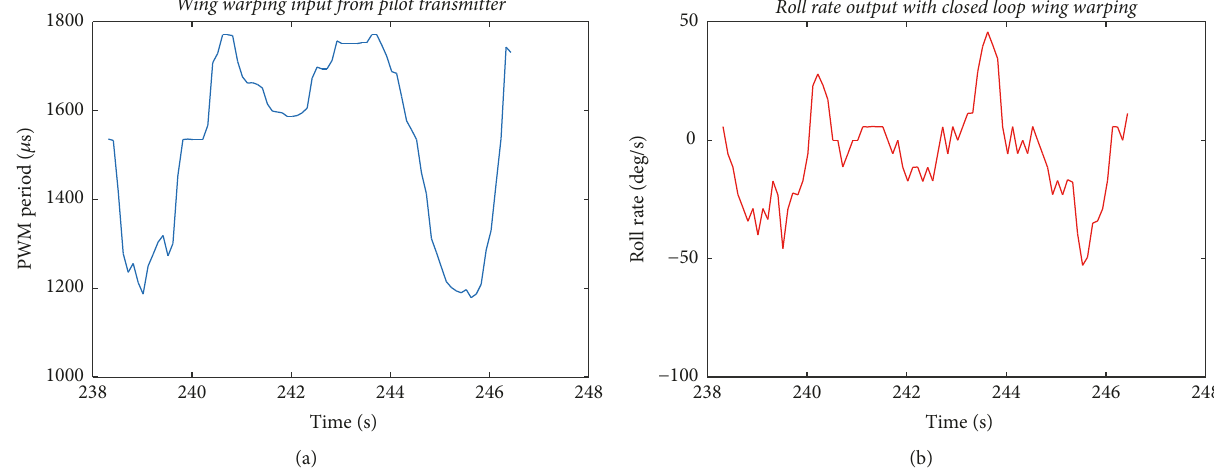
Figure 18: Roll rate of the FMW with open-loop wing warping double: (a) rudder inputs from pilot; (b) roll rates of the FMW mini-UAV. Wing warping input from pilot transmitter